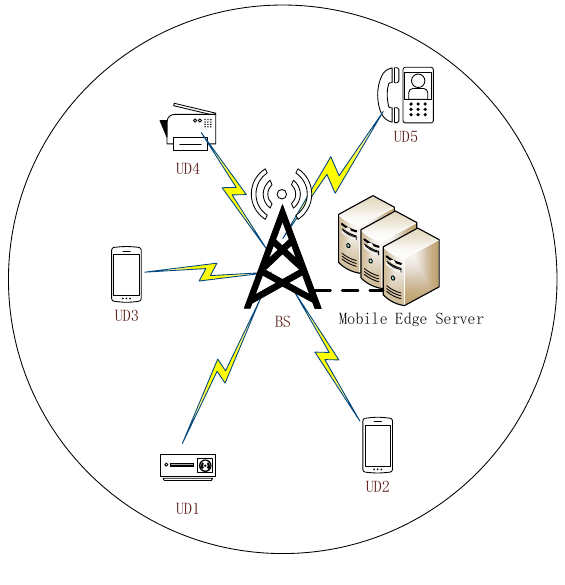
Figure 1. System model.